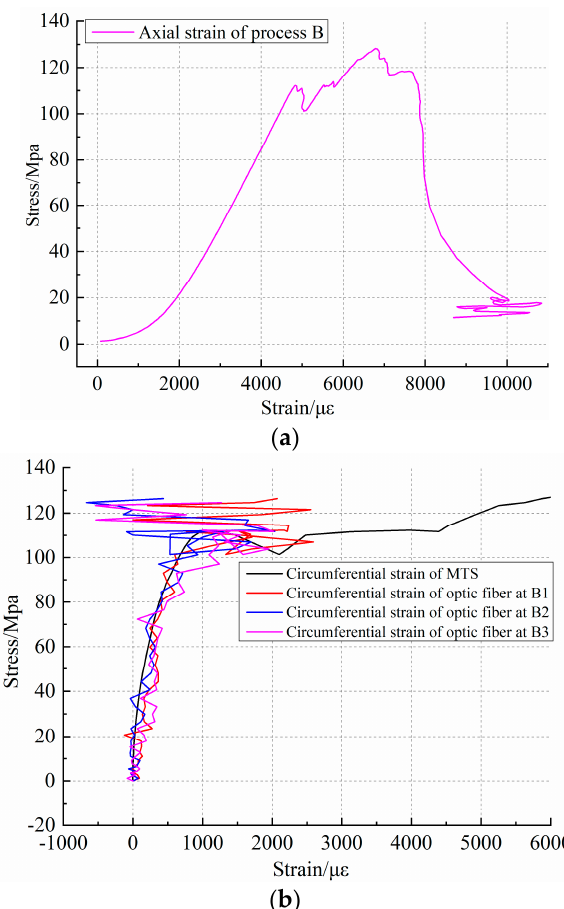
Figure 9. Fracture stress–strain results of No.3 rock sample; ( a ) shows axial stress–strain curve of No.3 rock sample under loading; ( b ) comparison of hoop strain measured by distributed optical fiber and MTS for No.3 rock sample.